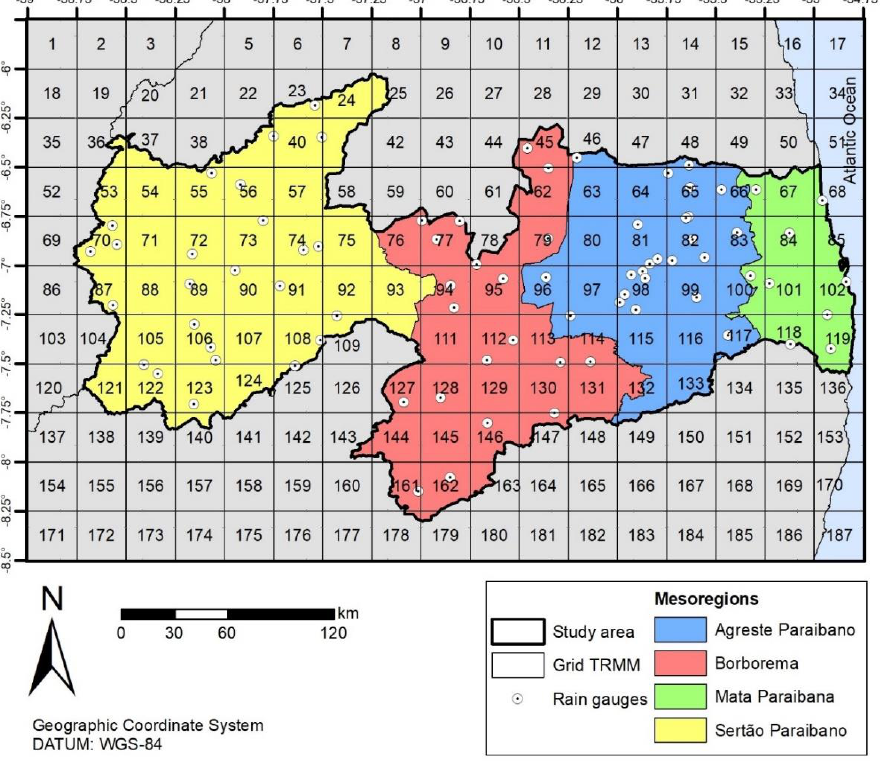
Figure 2. Tropical Rainfall Measuring Mission (TRMM) cell grid and spatial distribution of the rain gauges used over the study area.